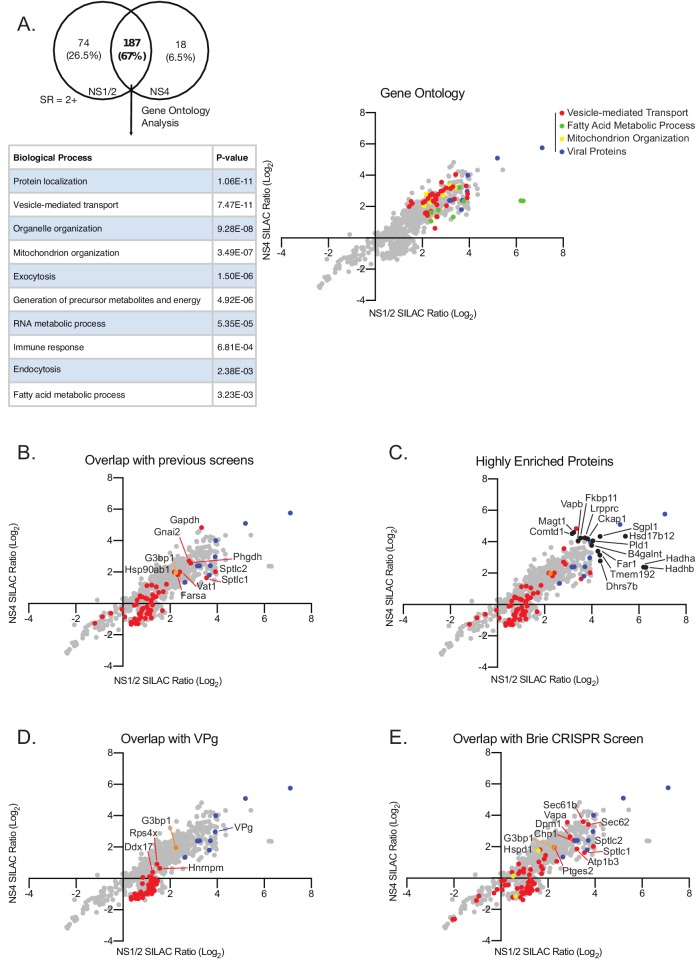
Additional analyses of NS1/2 and NS4-associated proteins.MNV proteins highlighted in light blue, and G3BP1 in gold. (A) Gene ontology using PANTHER overrepresentation analysis of proteins copurifying with NS1/2 or NS4 (Log2 SILAC ratio >2 for either protein). Proteins in selected, mutually exclusive gene ontology categories are plotted in different colours as depicted. (B) A number of factors previously identified as MNV host factors using proteomics or CRISPR approaches (Orchard et al., 2019; Chung et al., 2014; Vashist et al., 2012b) copurified in pulldowns of NS1/2 and NS4 (highlighted red). (C) Novel putative MNV host factors highly enriched (Log2 SILAC ratio >4 for either protein) by NS1/2 and NS4 are plotted in black. (D) Proteins identified in pulldowns of NS1/2 and NS4 which were also identified in pulldowns of MNV VPg are plotted in red. (E) Proteins enriched in pulldowns of NS1/2 and NS4 which were also identified using CRISPR screening as MNV host factors are plotted in red (positive host factors) and yellow (negative host factors), along with G3BP1 in gold.